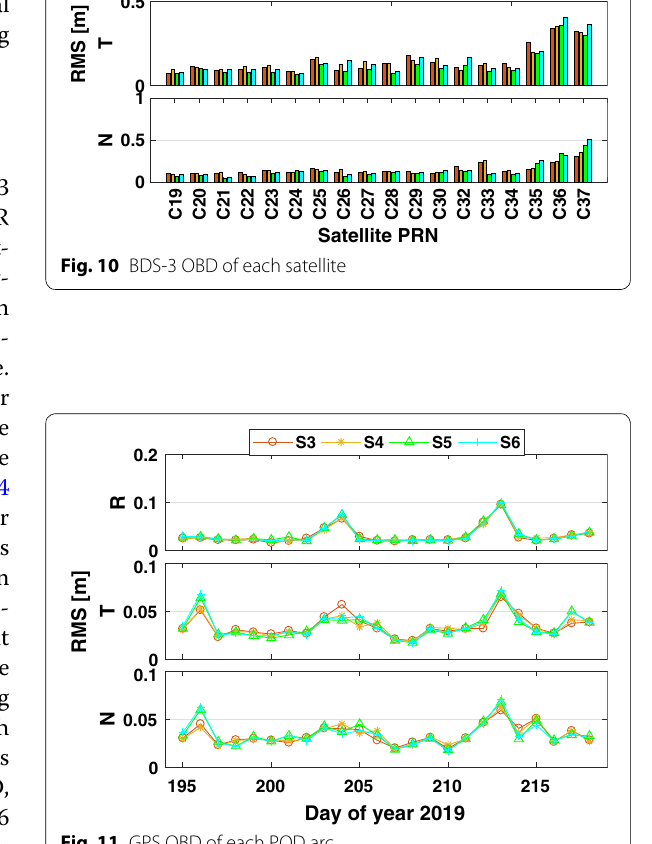
Fig. 11 GPS OBD of each POD